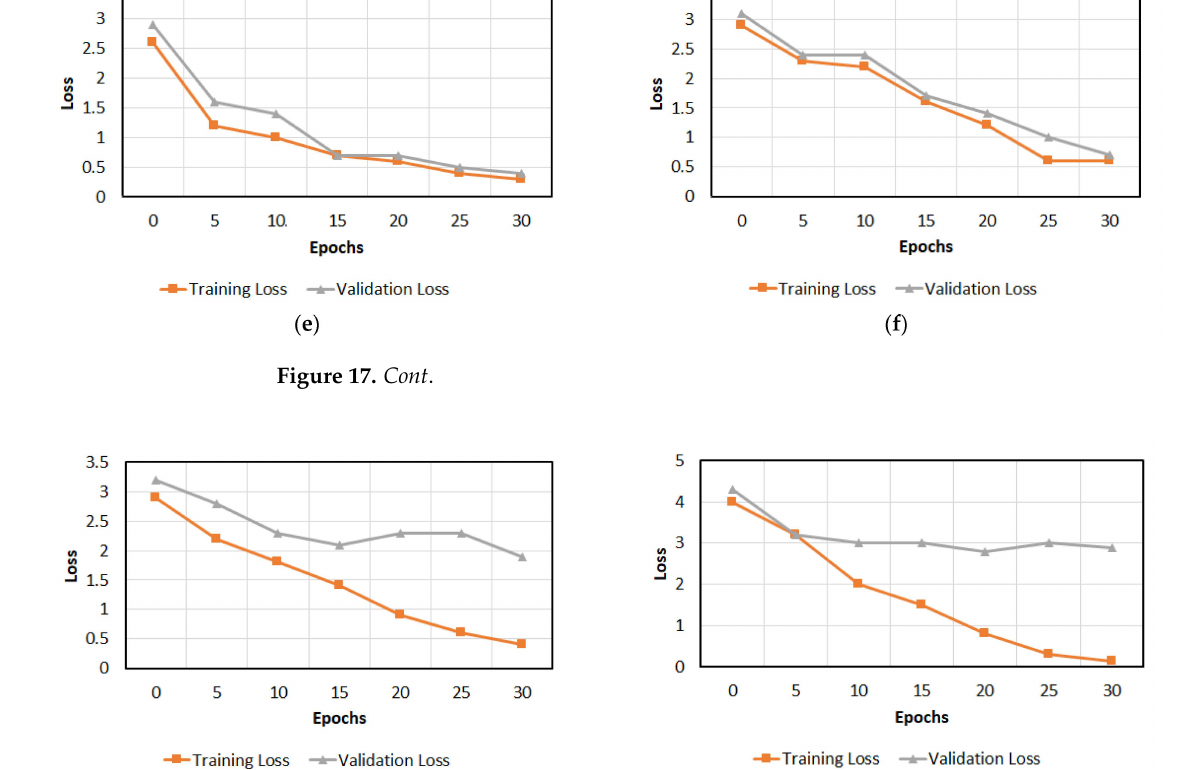
Figure 17. Training and validation loss curves. Curves obtained by using training sets with size of ( a ) 70%, ( b ) 50%, ( c ) 30%, ( d ) 10%. Curves obtained by using training sets augmented from training sets with size of ( e ) 70%, ( f ) 50%, ( g ) 30%, ( h )